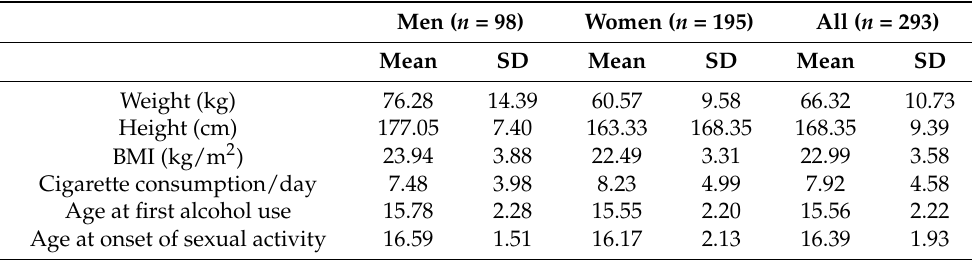
Table 2. Characteristics of participants by